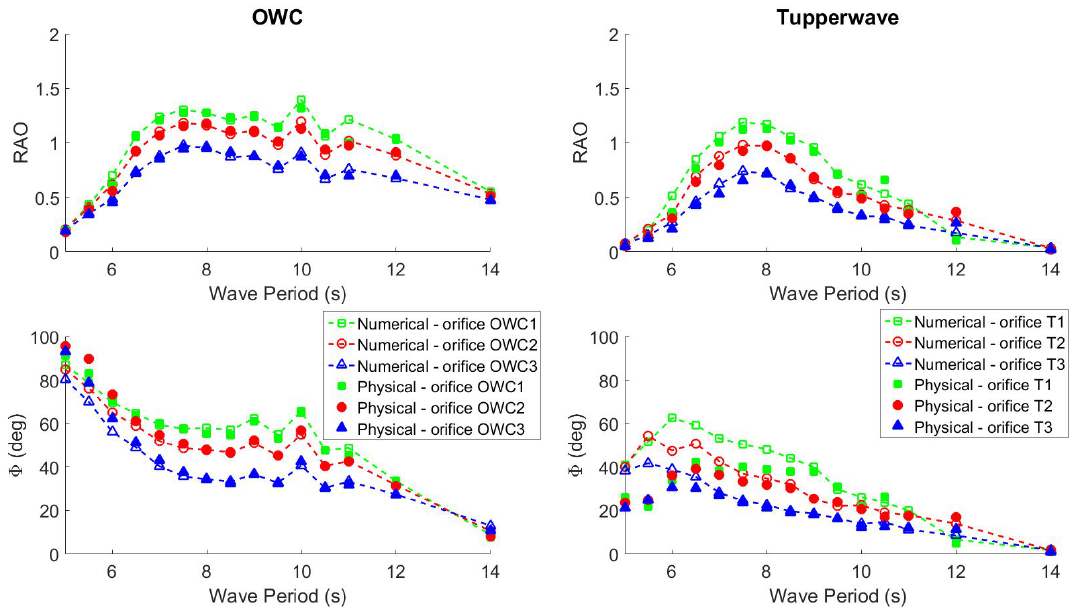
Figure 14. Response Amplitude Operator (RAO) of the buoy and water column relative motion and their phase difference for the conventional OWC and Tupperwave device in regular waves ( H = 2